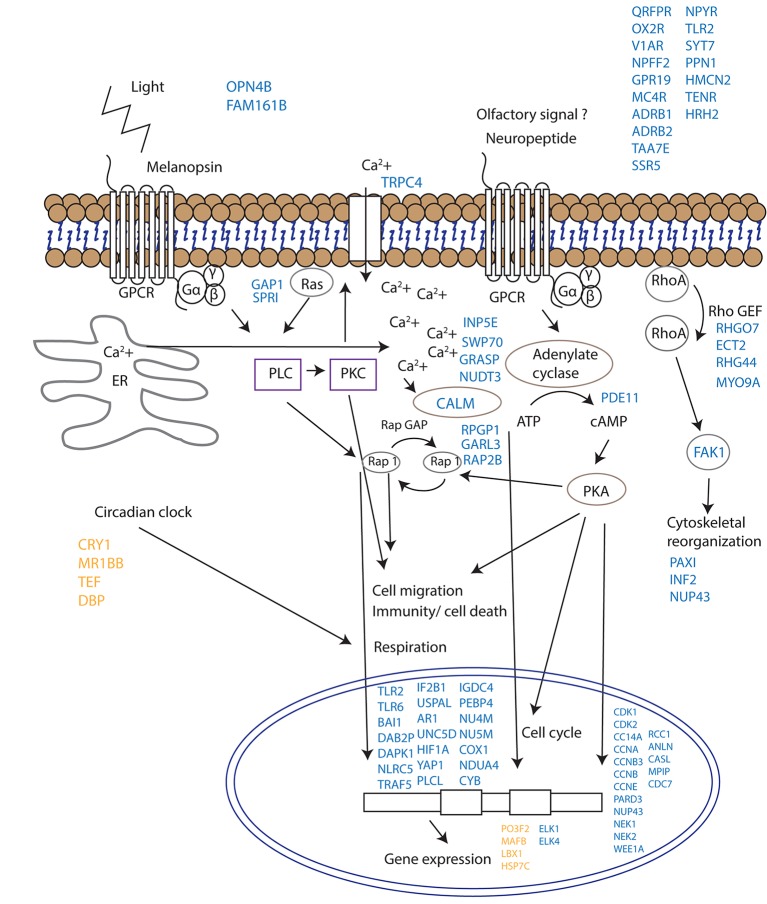
Proposed model for signalling events during spawning and gamete release in Acropora millepora.The release of gametes occurs in the presence of moonlight or another signal (such as an olfactory signal) that stimulates melanopsin-like homologs and/or other neuropeptides and commences GPCR signalling cascades upon receptor activation. This effect results in cell migration, follicle rupture, changes in immunity/cell death, respiration and cytoskeletal organization, and the combination of which results in a synchronized gamete release. Blue labels indicate genes being up-regulated; orange labels indicate genes down-regulated.